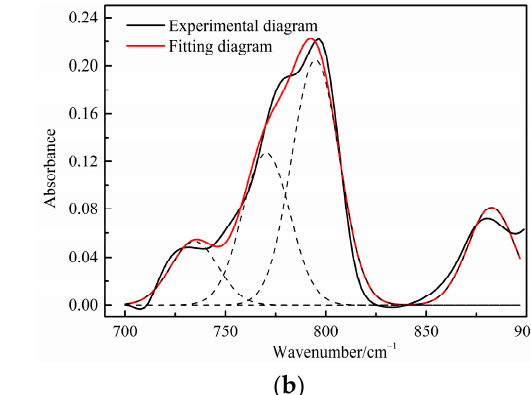
Figure 4. Curve-fitted FT-IR spectra of the aliphatic C–H stretching bands and ( a ) aromatic out-of- plane C-H stretching vibration ( b ) of spent shale obtained at a heating rate of 5 °C/min.